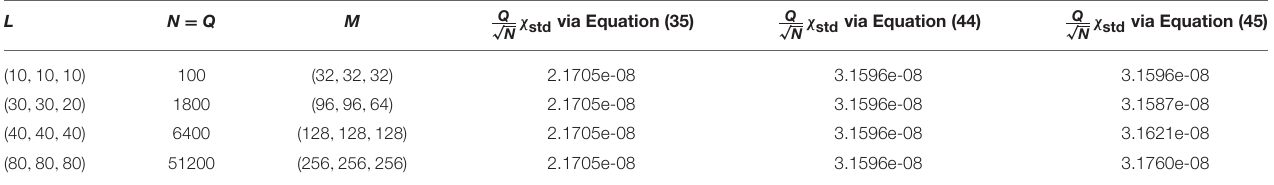
TABLE 1 | Computed values for Equations (35), (44), and (45) for different systems having the same particle and charge density (see the supposed values for L , N , and Q